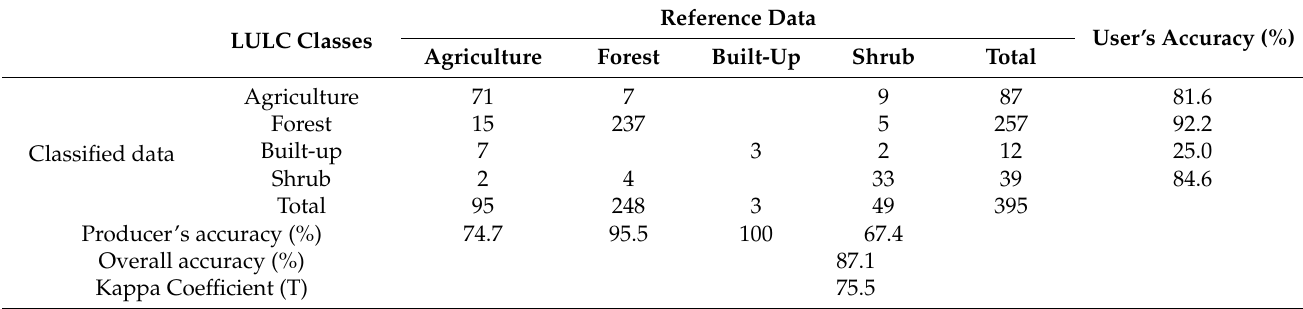
Table 4. Confusion matrix of land use classification in 2020.